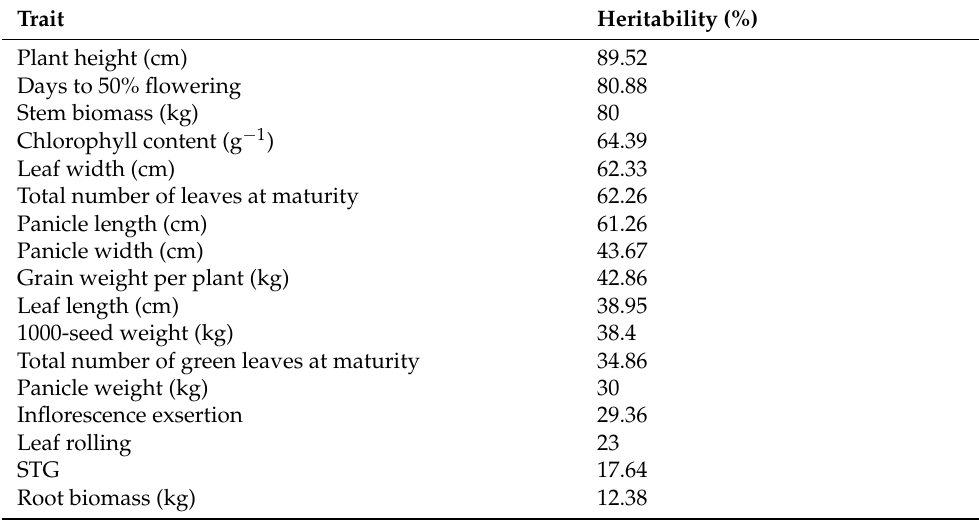
Table 10. Heritability of sorghum genotypes traits under water management